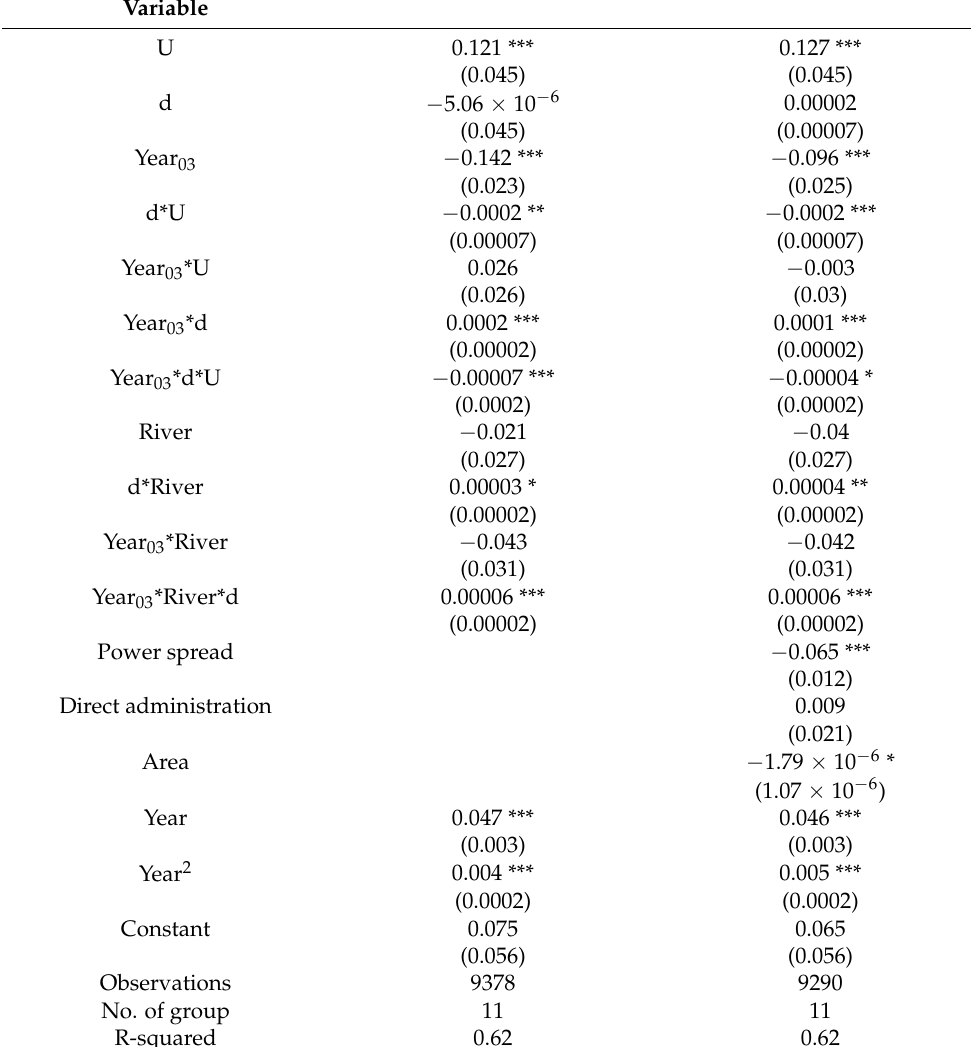
Table 9. Robust results—economic impact of building the TGD by setting 2003 as the basis